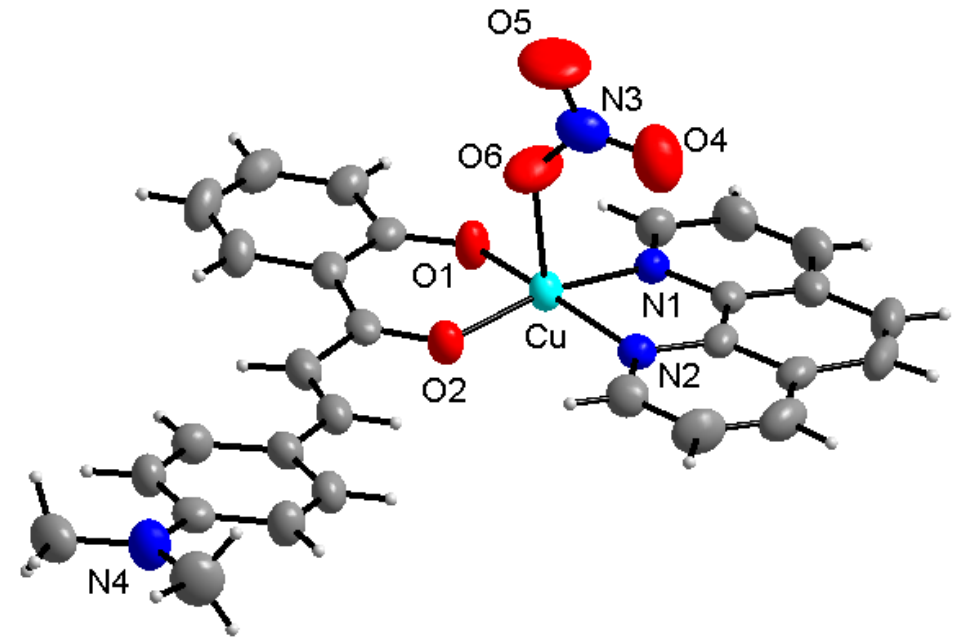
)] as determined by a single crystal X-ray analy- 3